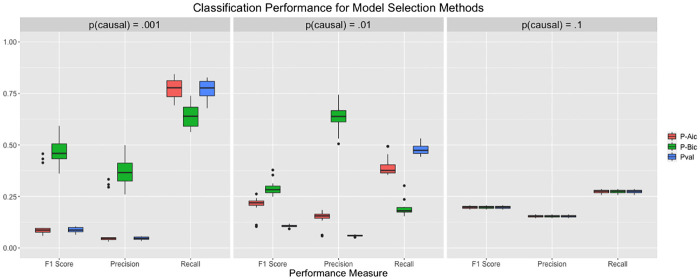
Performance of the selected models for each of the model selection methods across the different simulation settings of simulation 1, as measured by precision, recall, and F1 score.The leftmost box in each grouping of three corresponds to pseudo AIC, the center corresponds to pseudo BIC, and the rightmost corresponds to pseudovalidation. Models were selected from a set of candidate LassoSum models.